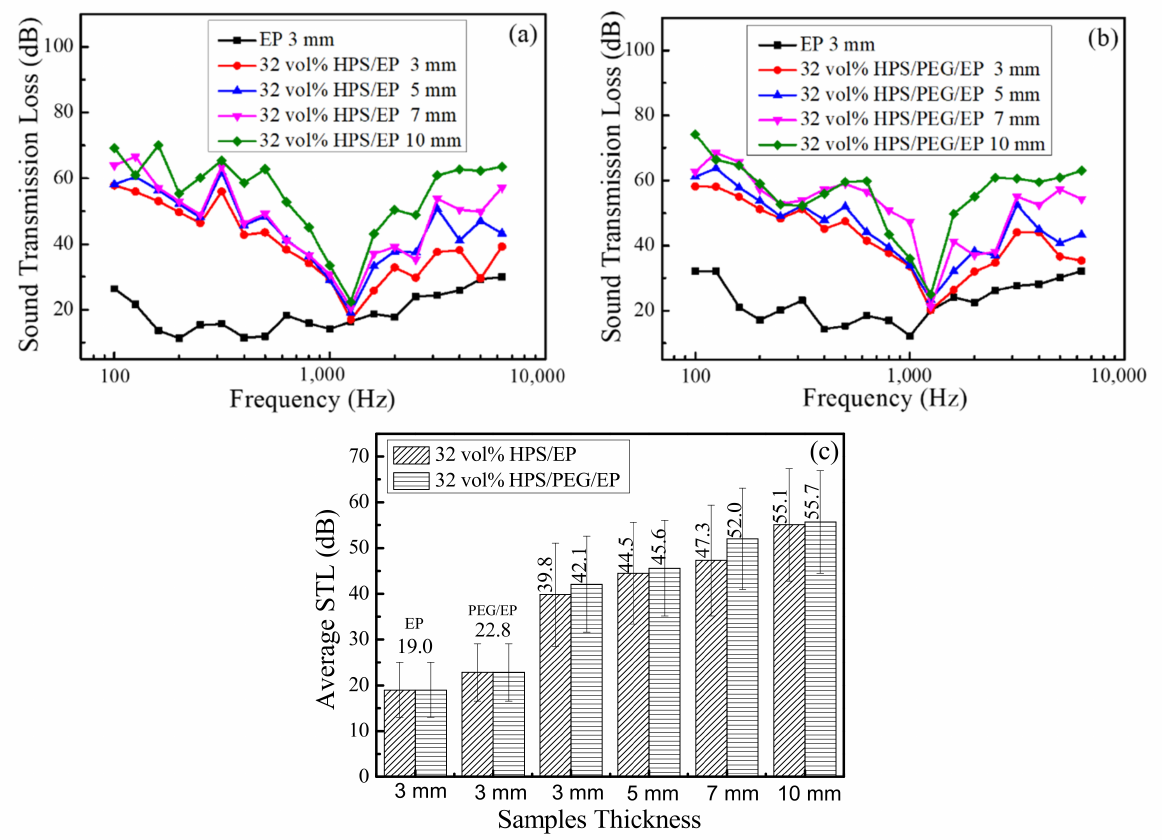
Figure 6. ( a ) Soundproof properties of the EP and HPS/EP composites with different thicknesses; ( b ) soundproof properties of the EP and HPS/PEG/EP composites with different thicknesses; ( c ) the average STL of the EP, HPS/PEG/EP, and the HPS/PEG/EP composites with different